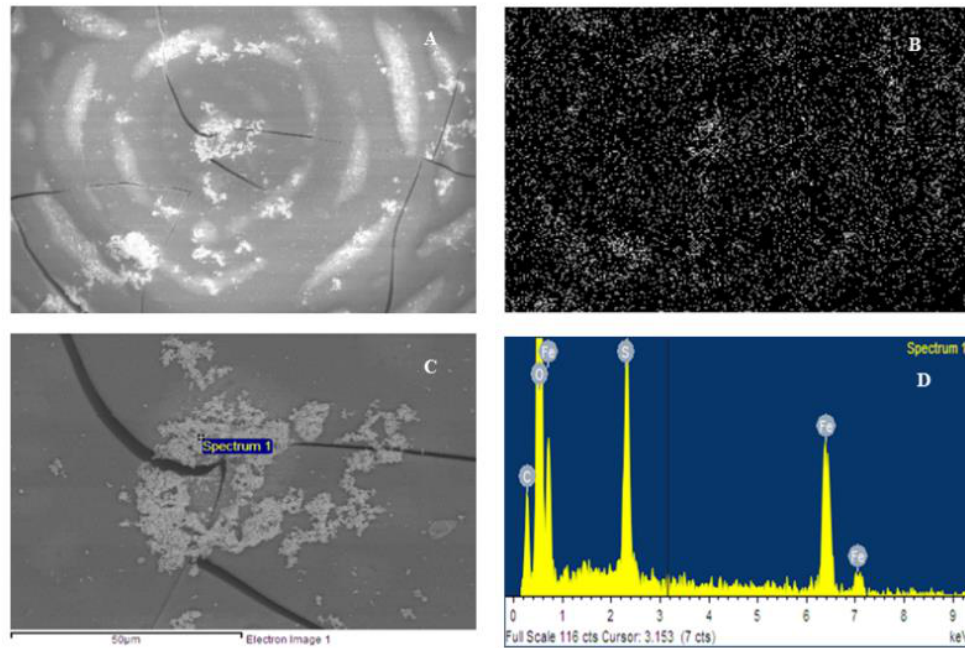
Figure 5. Scanning electron microscopy images of heterogeneous iron-based amberlite catalyst ( A ), mapping analysis of the iron distribution ( B ), electron amplified ( C ) and elemental mapping by Energy Dispersive Spectrometry of the region showed in image C ( D ).